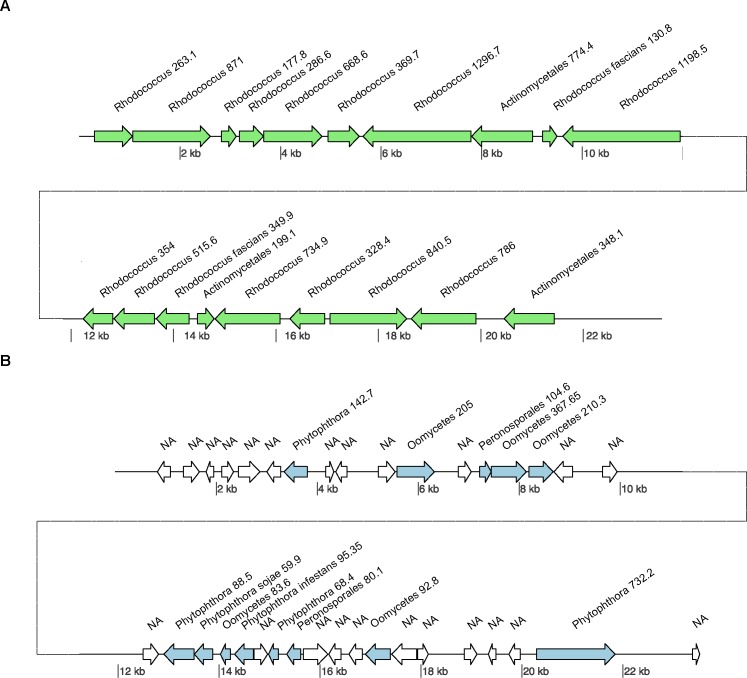
Taxonomic classification by CAT.Two contigs are depicted and per ORF a single top hit is shown. (A) Contig from the pre-assembly assigned by the CAT tool as bacterial, ORFs of bacterial origin are colored green, and ORF with no hits to the database are colored white. On this contig most ORFs had a highest blast hit with Rhodococcus species. The ΣBmax for this contig is 10982. and the highest ΣBtaxon is for the Rhodococcus genus at 9660, which is well above the cutoff of 5491 (ΣBmax * 0.5). The taxonomic origin of this contig was therefore assigned to the genus Rhodococcus, and as a consequence this contig was regarded as non-Pfs and removed. (B) Contig from the pre-assembly assigned by the CAT tool as an oomycete contig. On this contig all ORFs have a best hit to an oomycete species, and the ΣBmax is 2328. In fact, most ORFs have a best hit to species in the Phytophthora genus (ΣBtaxon: 1184), or the Peronosporales family (ΣBtaxon: 184). The ΣBtaxon for the Phytophthora genus is above the cutoff at 1164 (ΣBmax *0.5) thus assigning this contig to the Phytophthora genus, and consequently this contig is maintained for the Pfs genome assembly.